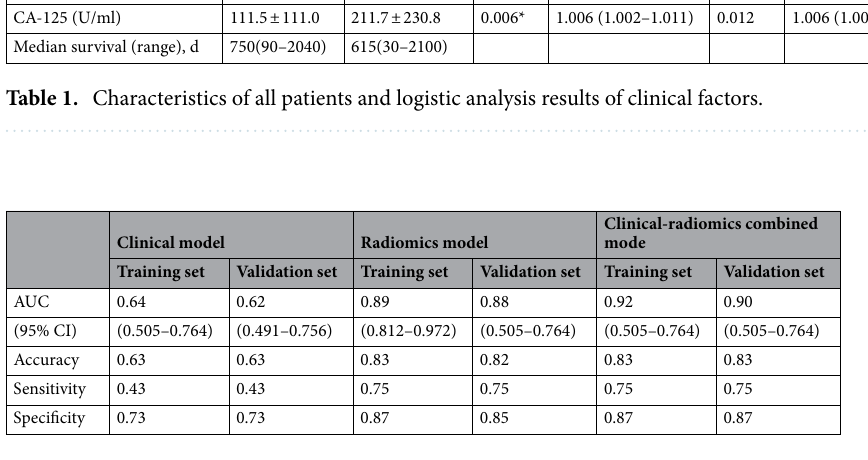
Table 2. AUC results of the combined clinical, radiomics, and clinical-radiomics models for predicting the pathological grading of